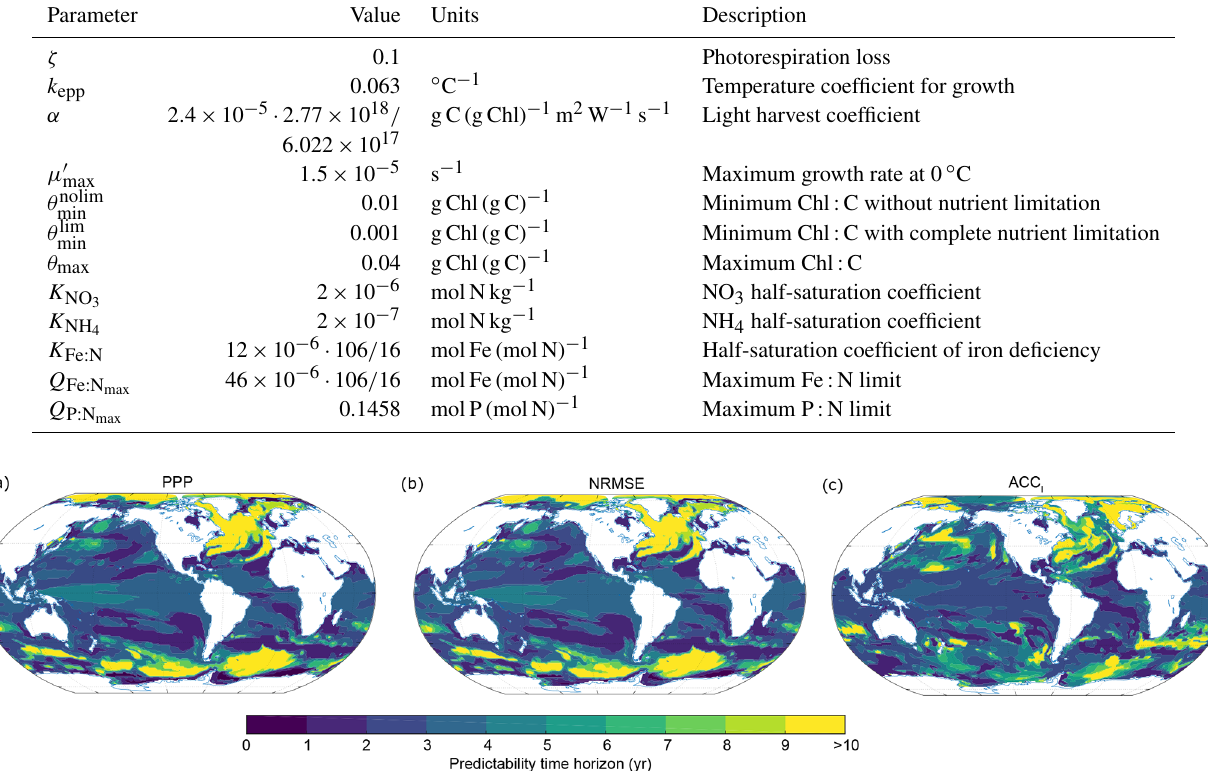
Figure B1. SST predictability time horizon calculated with different metrics. Spatial pattern of the predictability horizon for sea surface temperature using (a) PPP, (b) NRMSE and (c) ACC I . Note that we assume an arbitrary predictability threshold for ACC I so that the emerging pattern matches the PPP predictability best. This allows us to compare the relative differences in predictability.